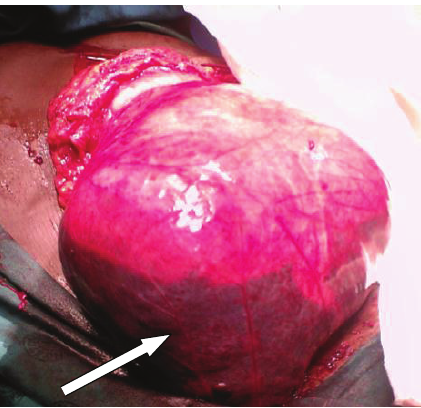
Figure 1: Peritoneal sac encountered at laparotomy; note free blood pooled at the bottom of the peritoneal sac (indicated by arrow).